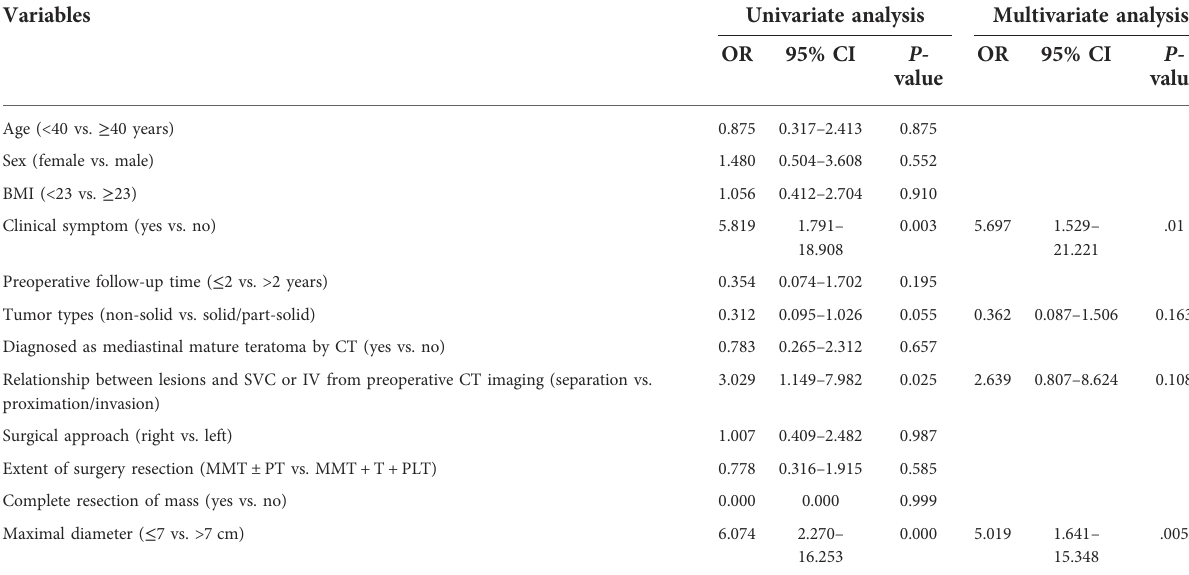
TABLE 5 Univariate and multivariate analysis of risk factors for increasing operation time.